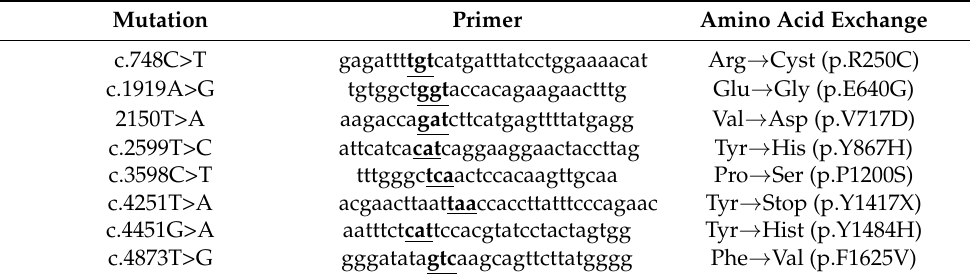
Table 1. Presentation of the mutations in the SI gene (see Reference [11]) that have been analyzed in this study, the resulting amino acid exchange and the sequence of the forward oligonucleotide primer used for generating the specific mutations in cDNA encoding SI . The modified nucleotide triplet is bold and